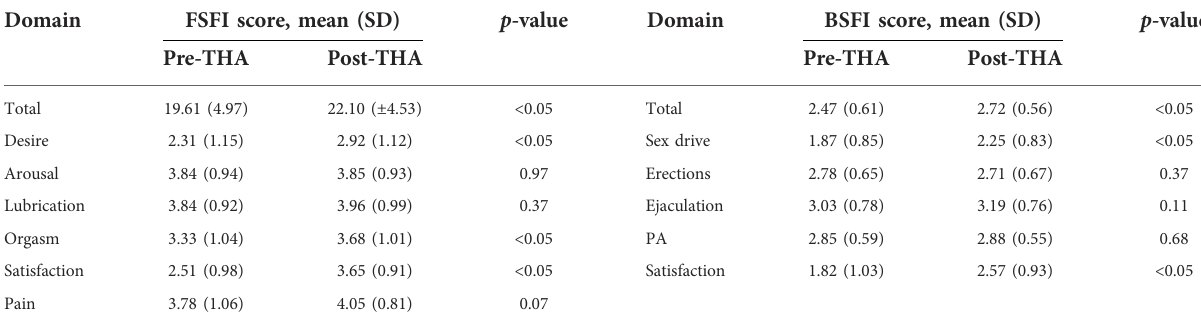
TABLE 2 FSFI and BSFI domain and total scores (average±SD) for our patient cohort. Domain